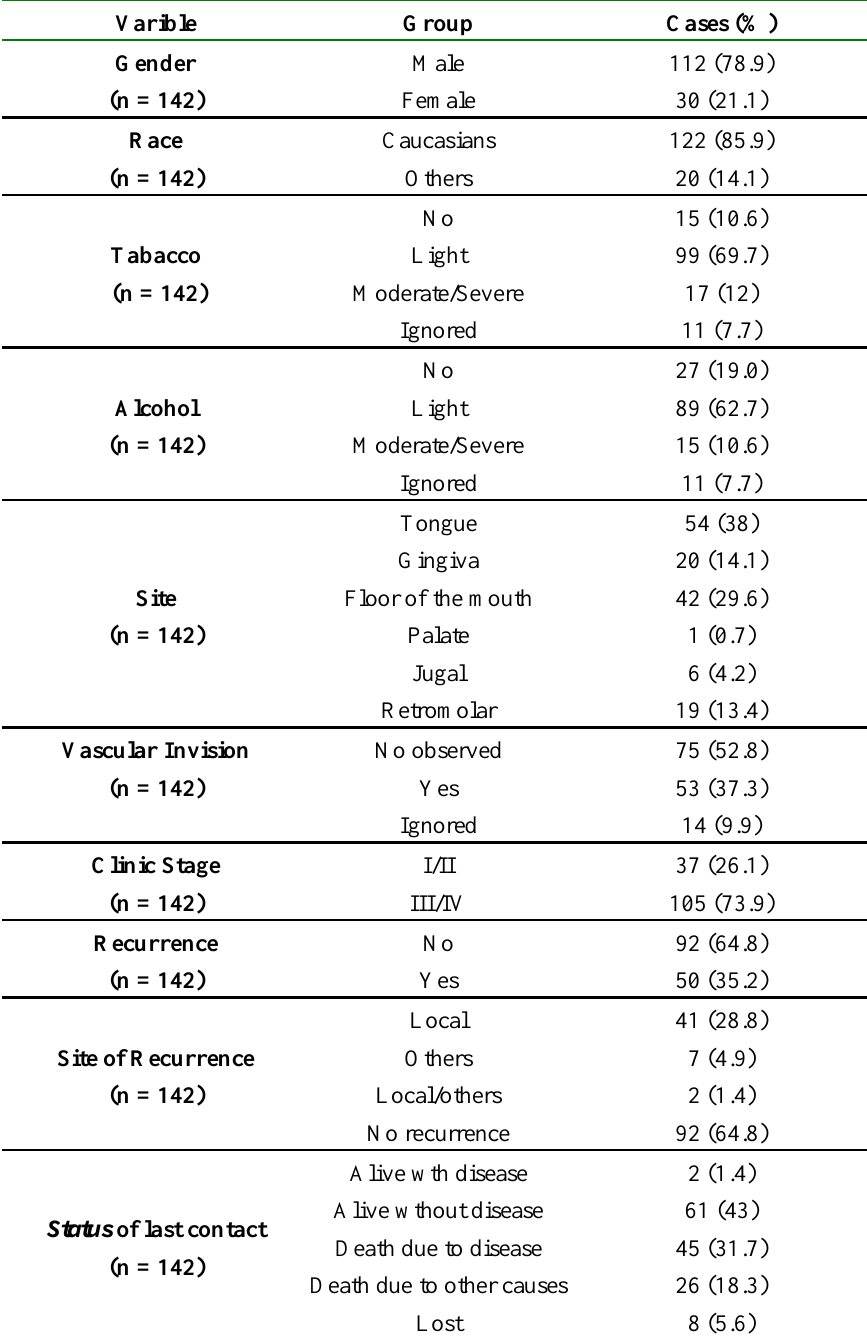
Table 1. Clinico-pathological information of OSCC